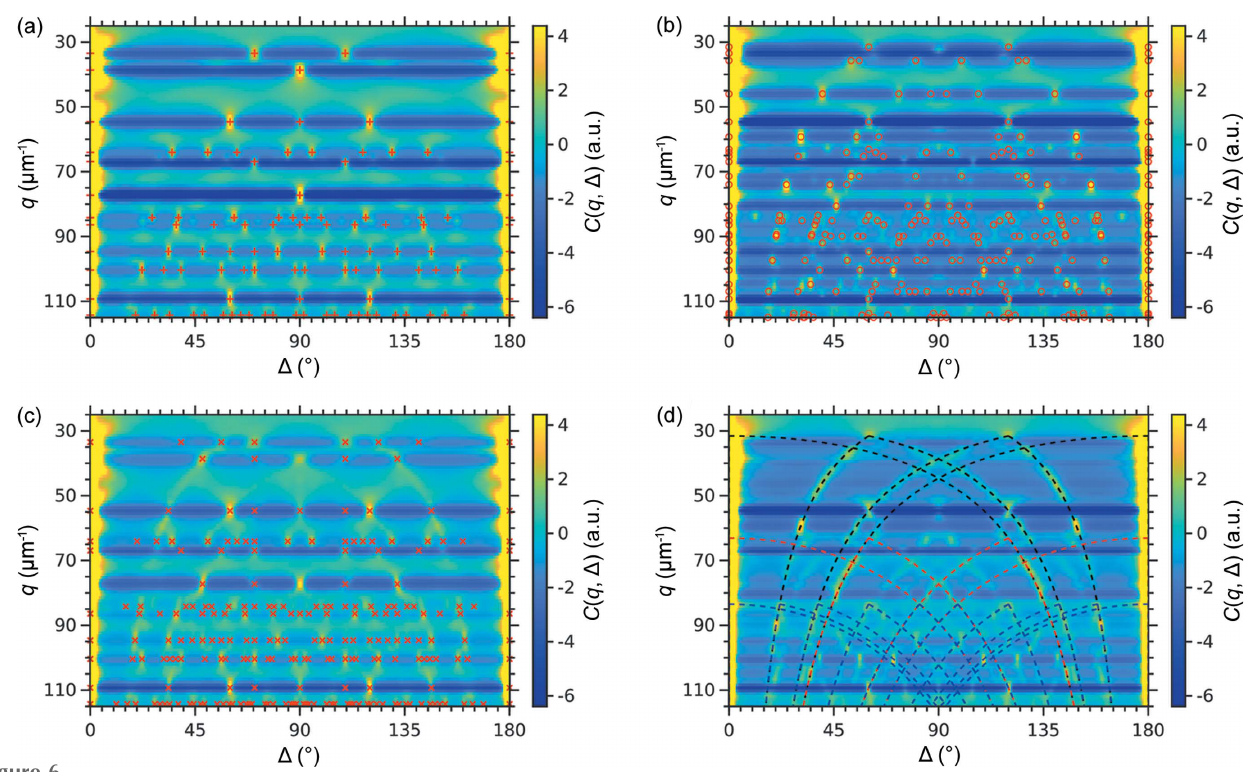
Figure 6 2D correlation maps C ( q , (cid:2) ) calculated in the q -range from 25 to 115 nm (cid:2) 1 for the simulated scattered intensities in 3D from ( a ) f.c.c. ( b ) h.c.p. ( c ) twinned f.c.c. and ( d ) r.h.c.p. structures. The CCFs are stacked together along the vertical axis q . The markers in ( a )–( c ) indicate the peak positions for the corresponding structures calculated from the geometrical model (see Appendix A). Note that in ( c ) there are only the peaks corresponding to the inter- domain correlations between the twin domains. The intra-domain correlations from each domain also produce peaks corresponding to an f.c.c. structure shown in ( a ). In ( d ) the dashed lines indicate the correlations between the Bragg rods. Only correlations within 10 l (black lines), 20 l (red lines) and 21 l (blue lines) Bragg rod families are shown. Correlations between the Bragg rods from different families as well as for higher order families have been omitted for